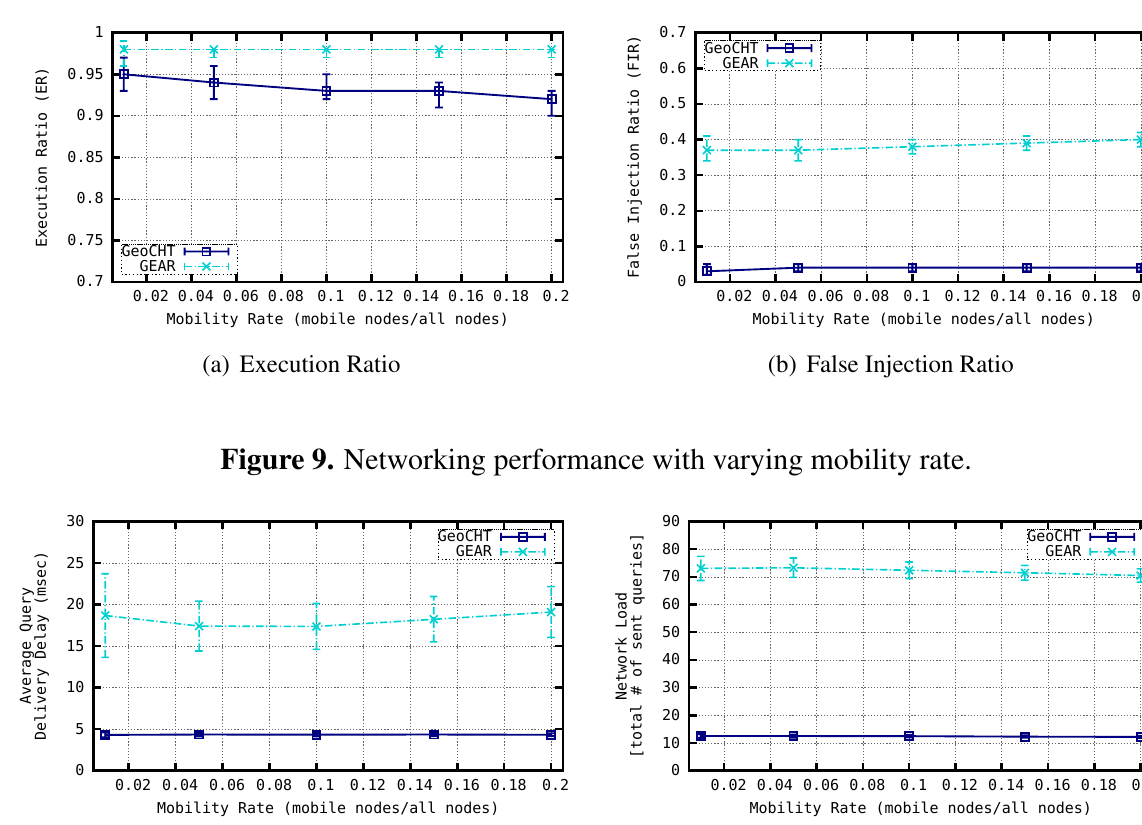
Figure 8. Routing accuracy performance with varying mobility rate.